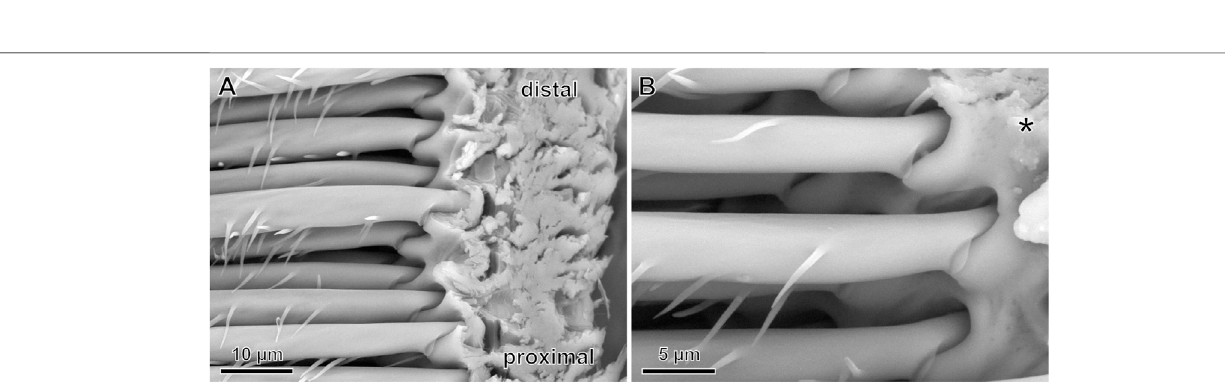
Frontiers in Mechanical Engineering |